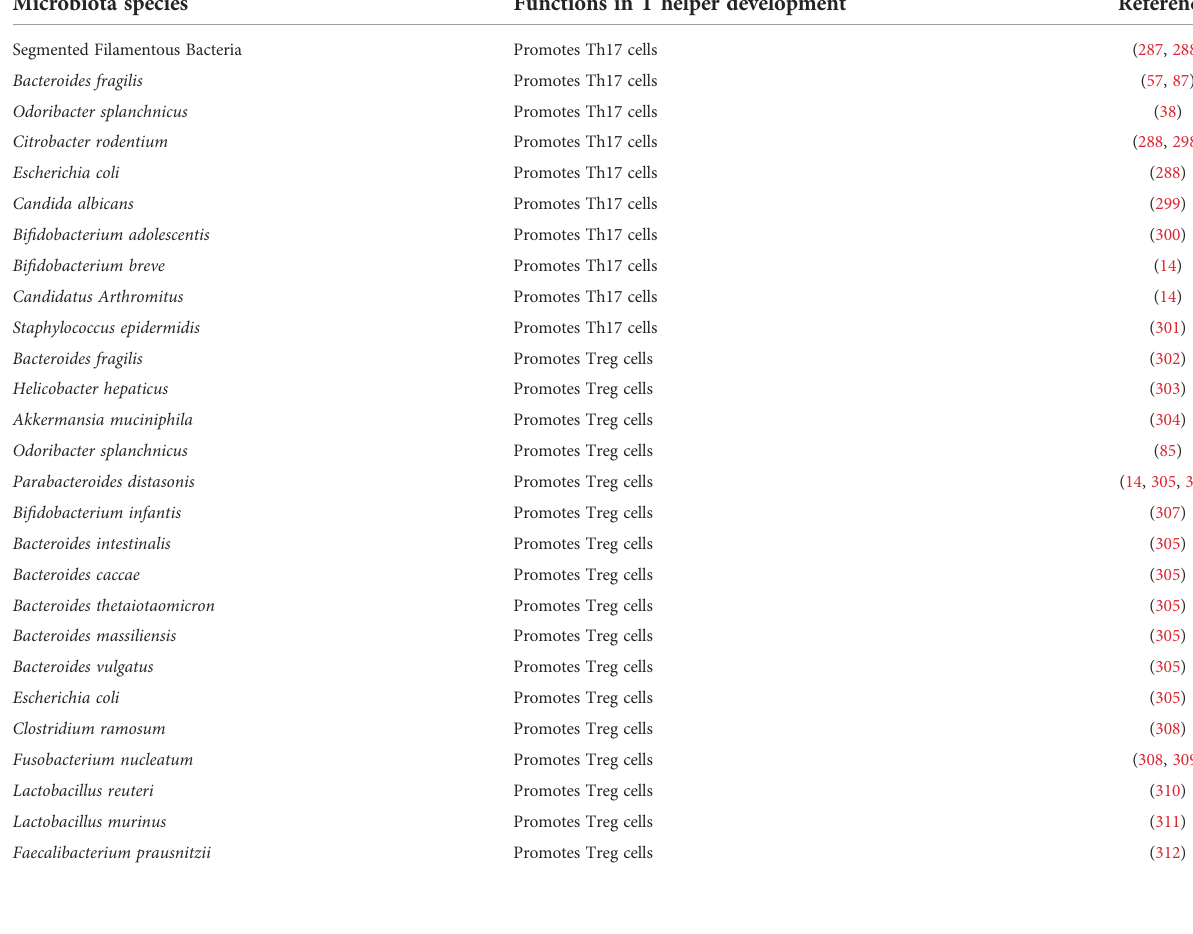
TABLE 3 Microbiota species in the activation and development of T helper